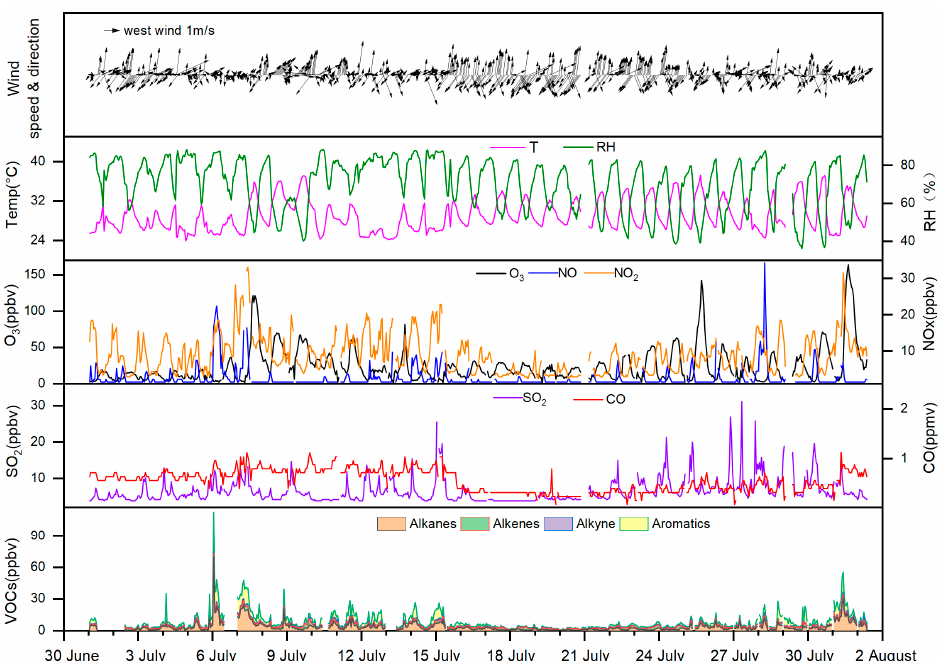
Figure 5. Time series of wind speed and direction, temperature (Temp) and relative humidity (RH), O 3 , NO, NO 2 , SO 2 , CO and VOCs concentrations at the HGS site.